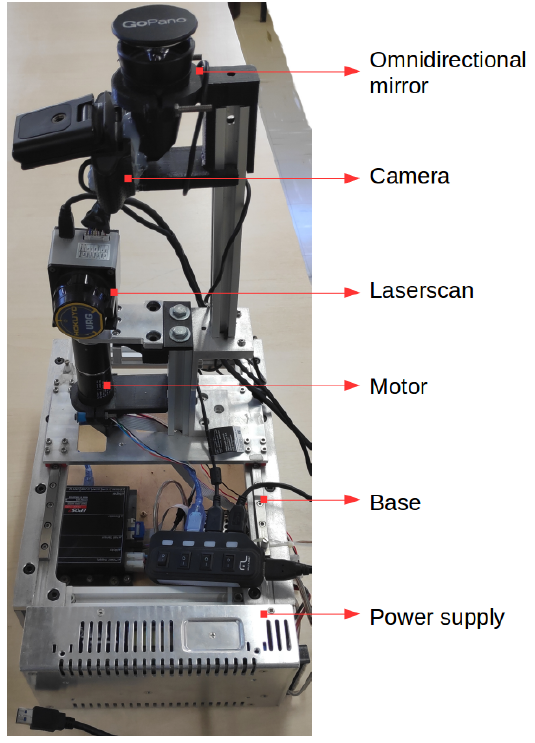
Figure 1. Layout of omnidirectional RGB-D sensor.